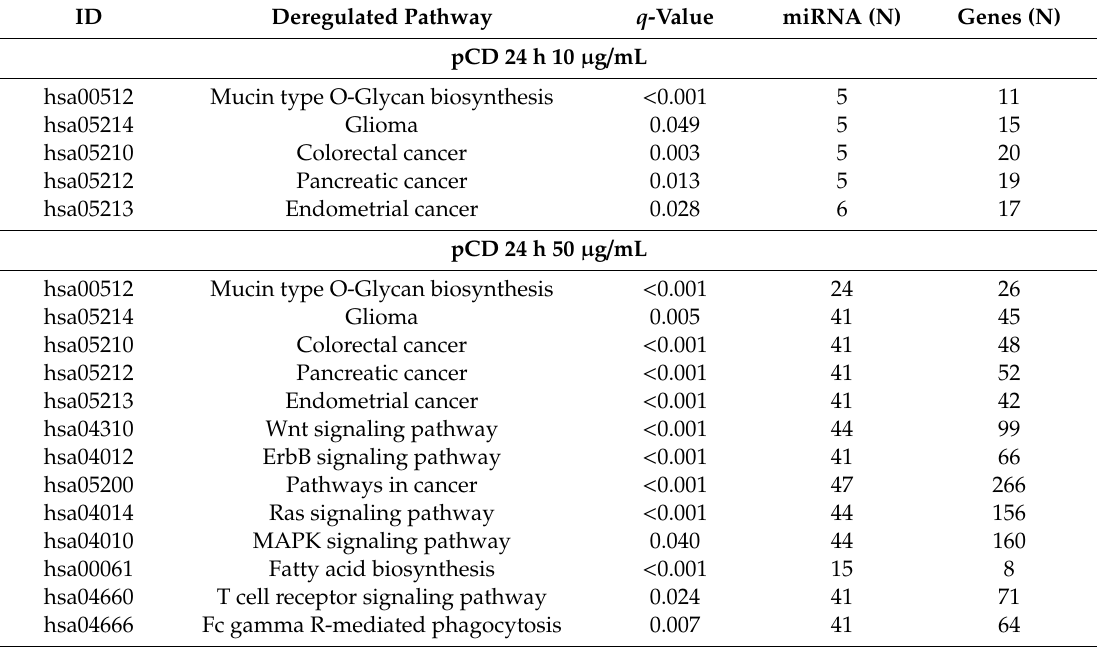
Table 3. Selected pathways based on miRNA-mRNA interactions deregulated after pCD NPs exposure.